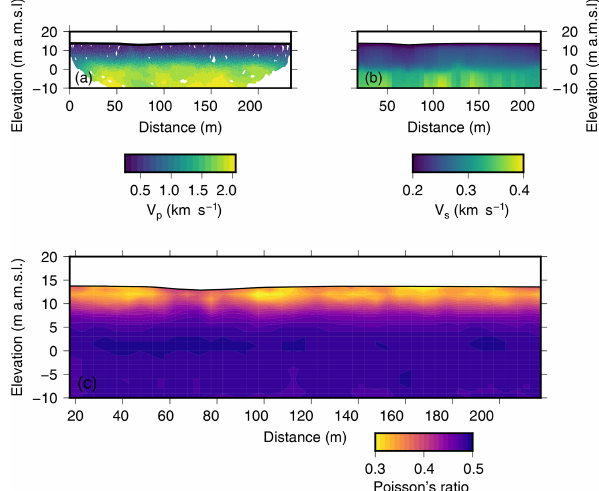
Figure 2. (a) The P-wave velocity results shown at 2 × vertical ex- aggeration. Areas where no rays pass through a model cell have been masked out. (b) The S-wave velocity results shown at 2 × ver- tical exaggeration. This image shows the 42 1D inversions side by side; no interpolation has been applied. (c) Profile of Poisson’s ratio calculated using Eq. (1) and the profiles shown in (a) and (b)